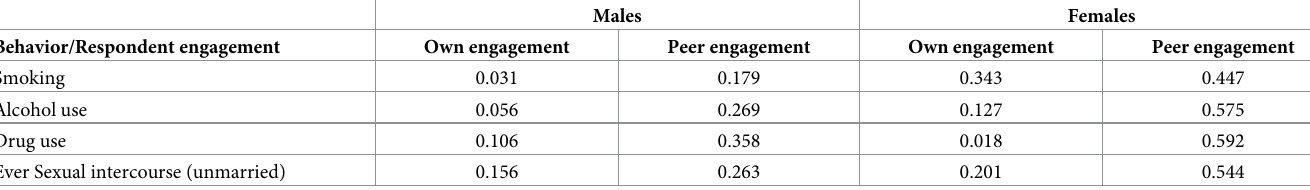
Table 2. Intracluster correlation coefficients (ICCs) for own and peers’ engagement in risk behaviors.